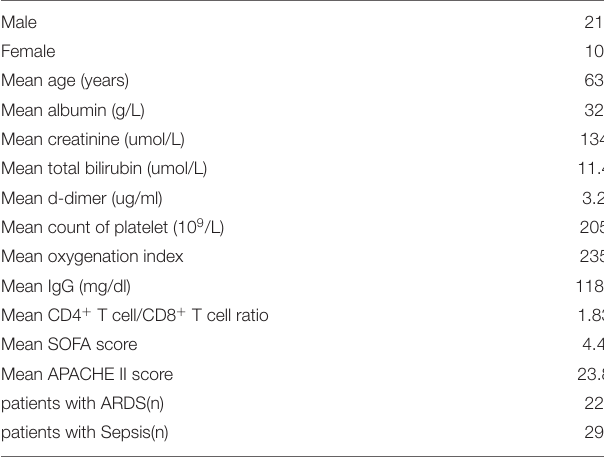
TABLE 1 | Clinical characteristics of 31